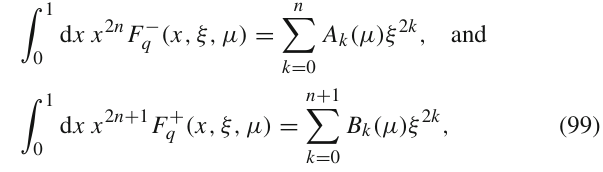
Fig. 4 Non-singlet leading-order ERBL evolution from μ 0 = 1 GeV to different values of the final scale μ of the distribution in Eq. (97) with n = 2. The upper inset displays the distributions obtained by numerically solving Eq. (28) with ξ = 1, while the bottom inset shows the ratio to Eq. (98). Note that the curves in the bottom inset overlap almost completely, making them hardly